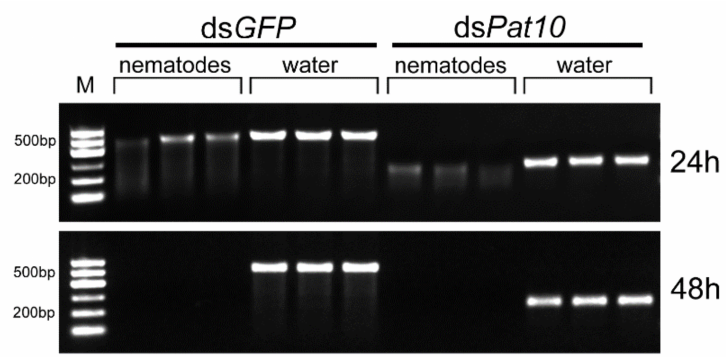
Figure 2. Agarose gel electrophoresis results of dsRNA and nematodes soaked for 24 and 48